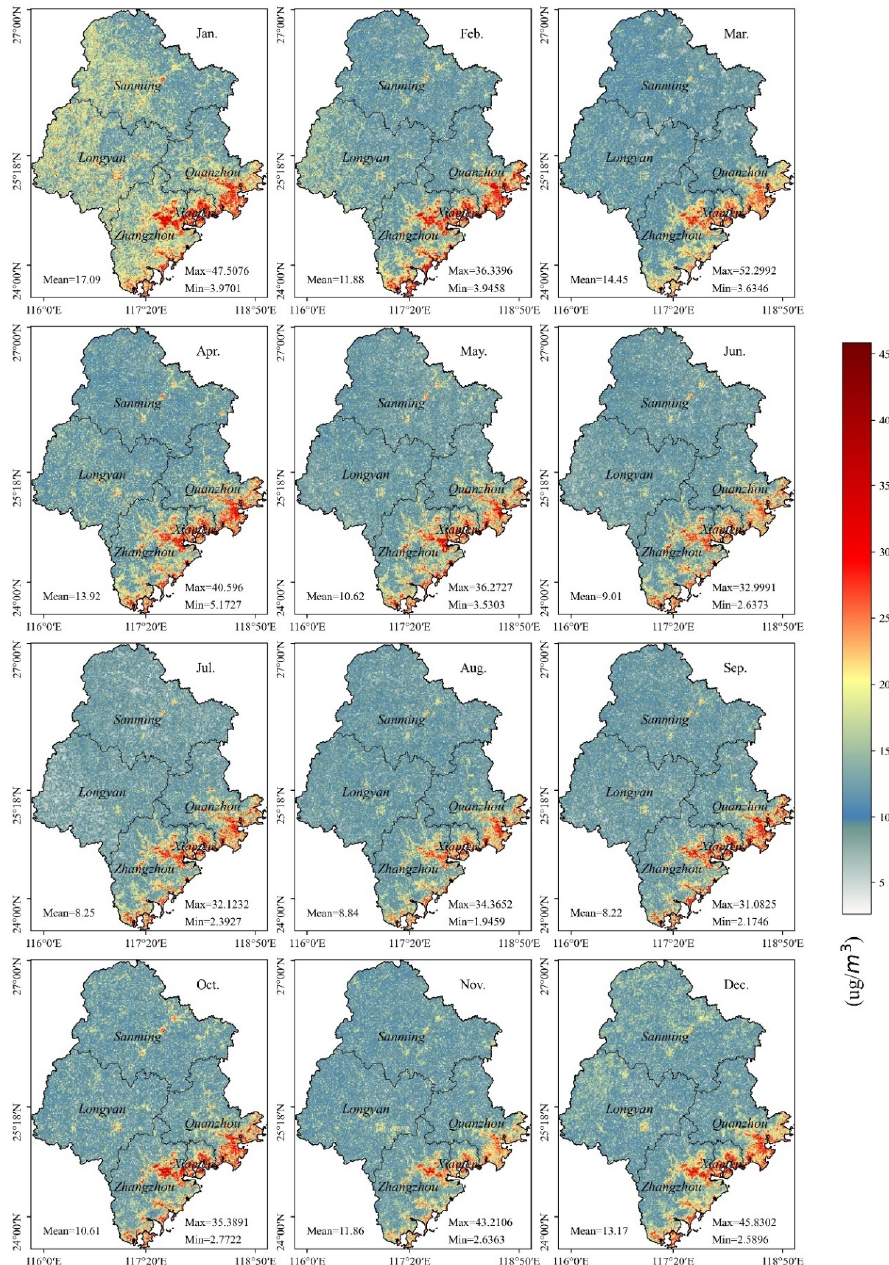
Figure 7. Monthly NO 2 spatial distribution in SWFJ in 2018. Jan. Feb. Mar. Apr. May Jun. Jul. Aug. Sep. Oct. Nov. Dec. represents the average of the daily NO 2 concentration distribution in 2018 each month. Mean, Max and Min represent the average, maximum, and minimum of monthly average pixels, respectively. The red highlighted region represents the high NO 2 concentration value, and the blue part represents the low NO 2 concentration value. The color bar on the right represents the NO 2 concentration.